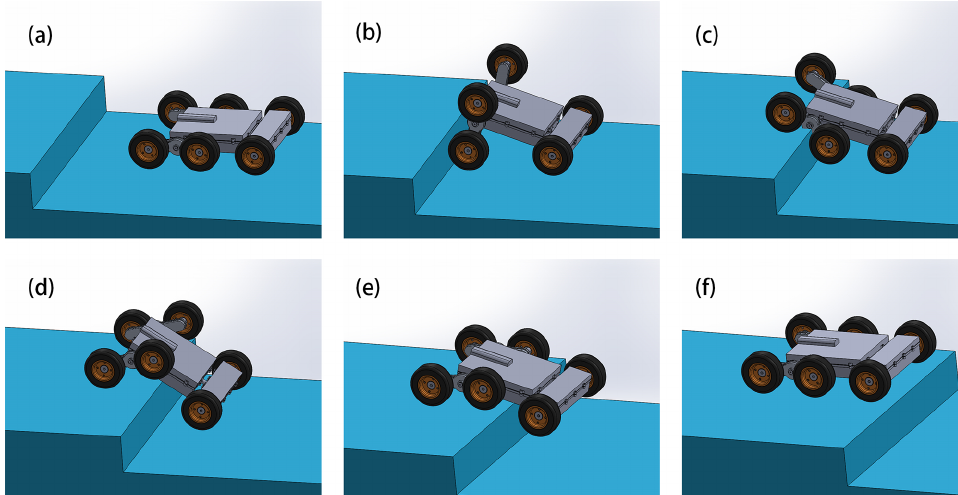
Figure 5. Obstacle crossing process of the robot.